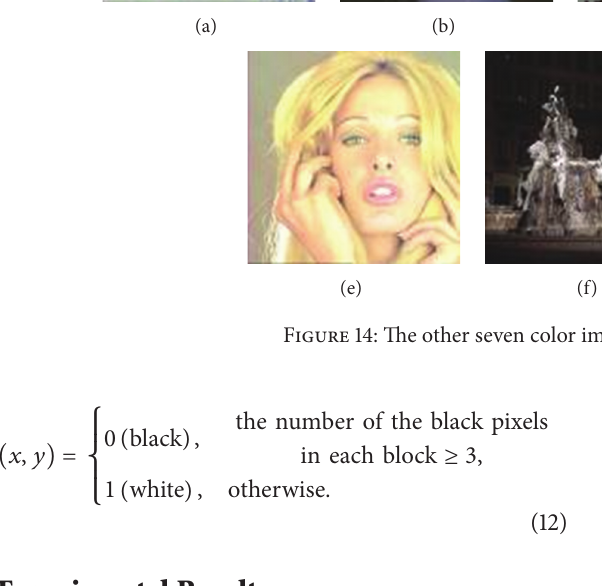
{{ the number of the black pixels {0 ( black ) , 𝐿 (𝑥, 𝑦) = in each block ≥ 3, {{ 1 ( white ) , otherwise